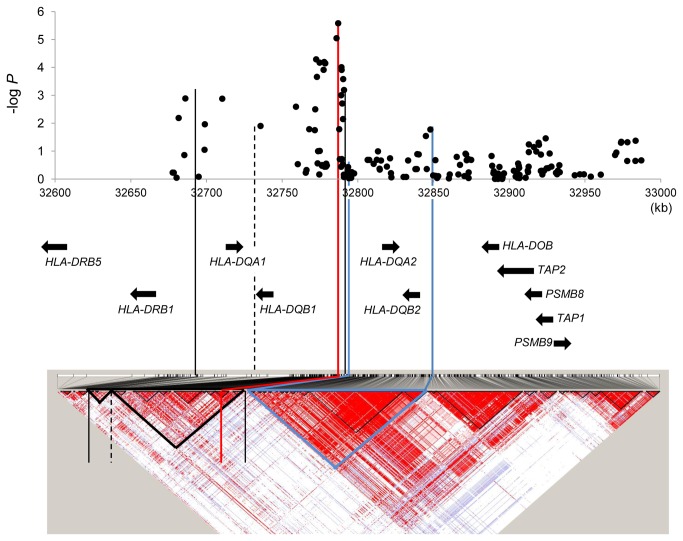
Linkage disequilibrium structure around the HLA-DQ region based on D’ using HapMap-JPT Data.P-value plot and genomic structure of the GWAS stage. Blue lines represent the LD block containing the HLA-DQA2 and HLA-DQB2 loci. Black lines represent two LD blocks containing the HLA-DQA1 and HLA-DQB1 loci, and the black dotted line represents the boundary between them. The red line represents the most strongly associated SNP, rs9275572, which is located within the HLA-DQB1 locus. The LD maps were created using HaploView software.